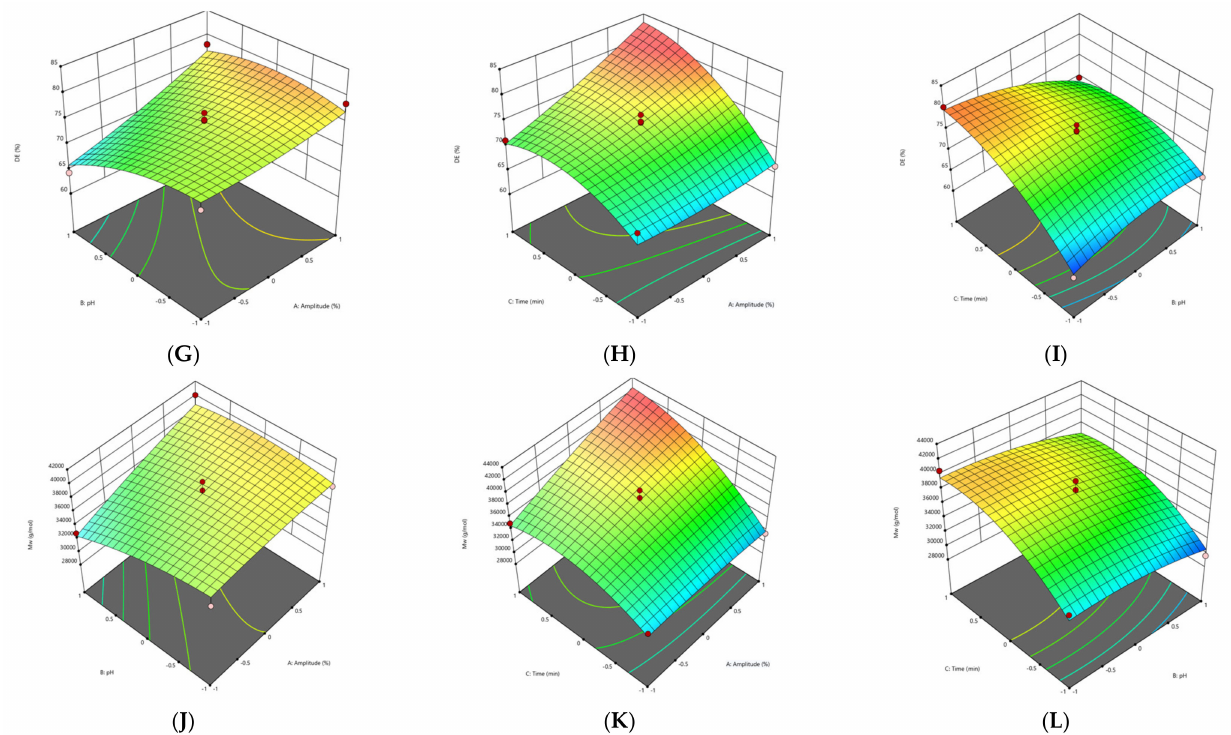
Figure 3. 3D graphs showing the influence of extraction parameters on the yield ( A – C ), GalA content